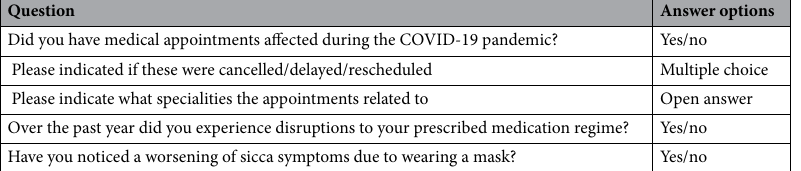
eleven visual function domains; general vision, ocular pain, near and distance vision, vision specific (VS) social functioning, mental health, role difficulties and dependency, driving, colour and peripheral vision. Each sub- scale is converted into a total score ranging from 0 to 100, with a higher score indicating better VR-QoL. Short form‑36 (SF‑36). The SF-36 is a generic measure of perceived HR-QoL in eight domains of patients day to day life. These include physical function, role physical, bodily pain, general health, vitality, social func- tion, role emotional, and mental health. Subscales are calculated ranging from 0 to 100 within each subscale. Higher scores indicated better HR-QoL. Physical Component Summary (PCS) and Mental Component Sum- mary (MCS) scores were calculated as recommended by Ware et al. 24 . Results were weighted against gender and age, and compared to normative data 25 .